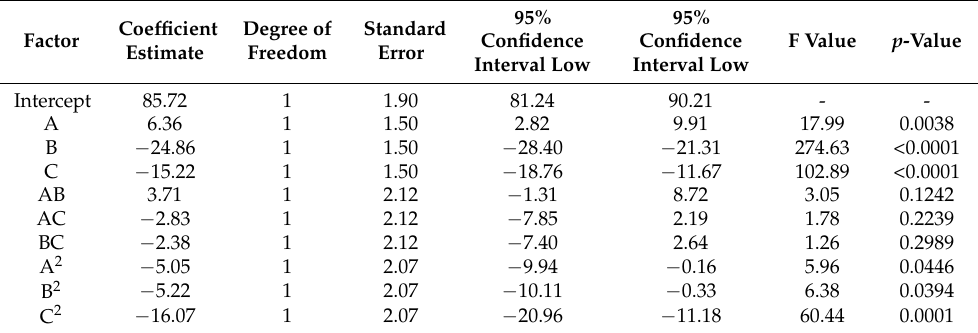
Table 5. Coefficients of the second-order polynomial (quadratic)